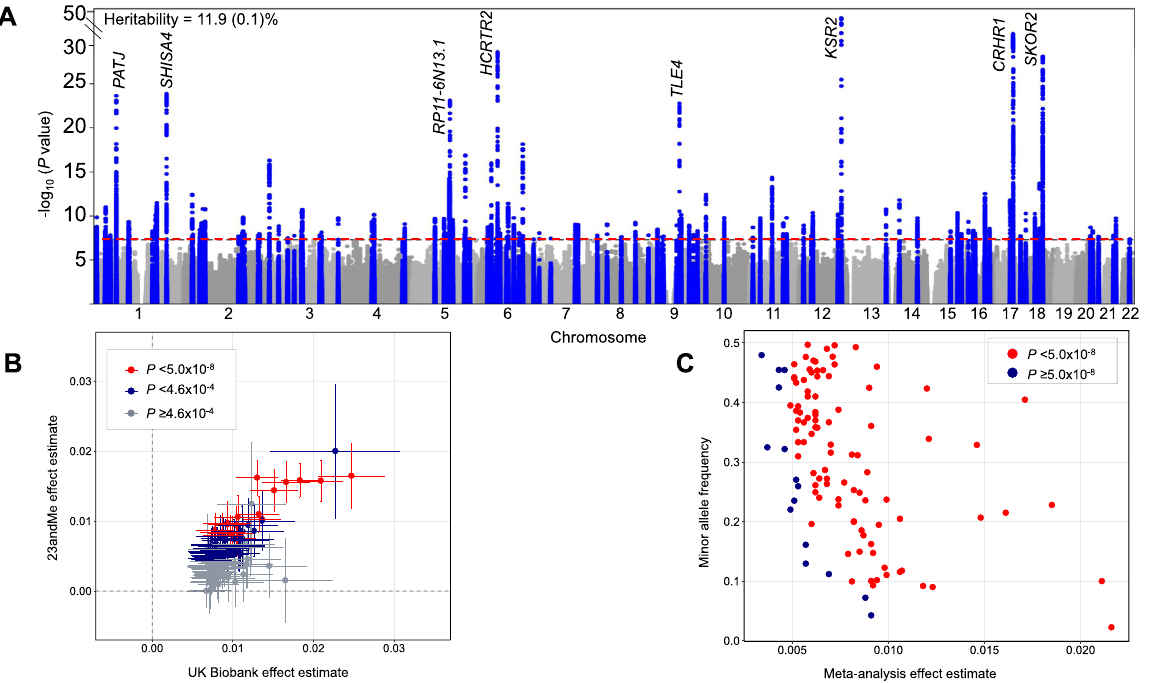
Fig. 1 Plots for genome-wide association analysis results for daytime napping in the UK Biobank ( n = 452,633) and replication in 23andMe ( n = 541,333). A Manhattan plot of daytime napping genome-wide association study in the UK Biobank ( n = 452,633). Plot shows the − log 10 P values ( y -axis) for all genotyped and imputed single-nucleotide polymorphisms (SNPs) passing quality control (BOLT-LMM mixed-model association test P values) ordered by chromosome and base position ( x -axis). Blue peaks represent genome-wide signi fi cant loci. Horizontal red line denotes genome-wide signi fi cance ( P = 5 × 10 − 8 ). Top 8 loci are annotated with nearest gene. B Daytime napping signals ’ effect estimates from UK Biobank ( n = 452,633) plotted against effect estimates from 23andMe ( n = 541,333). Error bars represent the 95% con fi dence intervals for each effect estimate. C Effect estimates of daytime napping signals from UK Biobank and 23andMe meta-analysis (total n = 993,966) plotted against minor allele